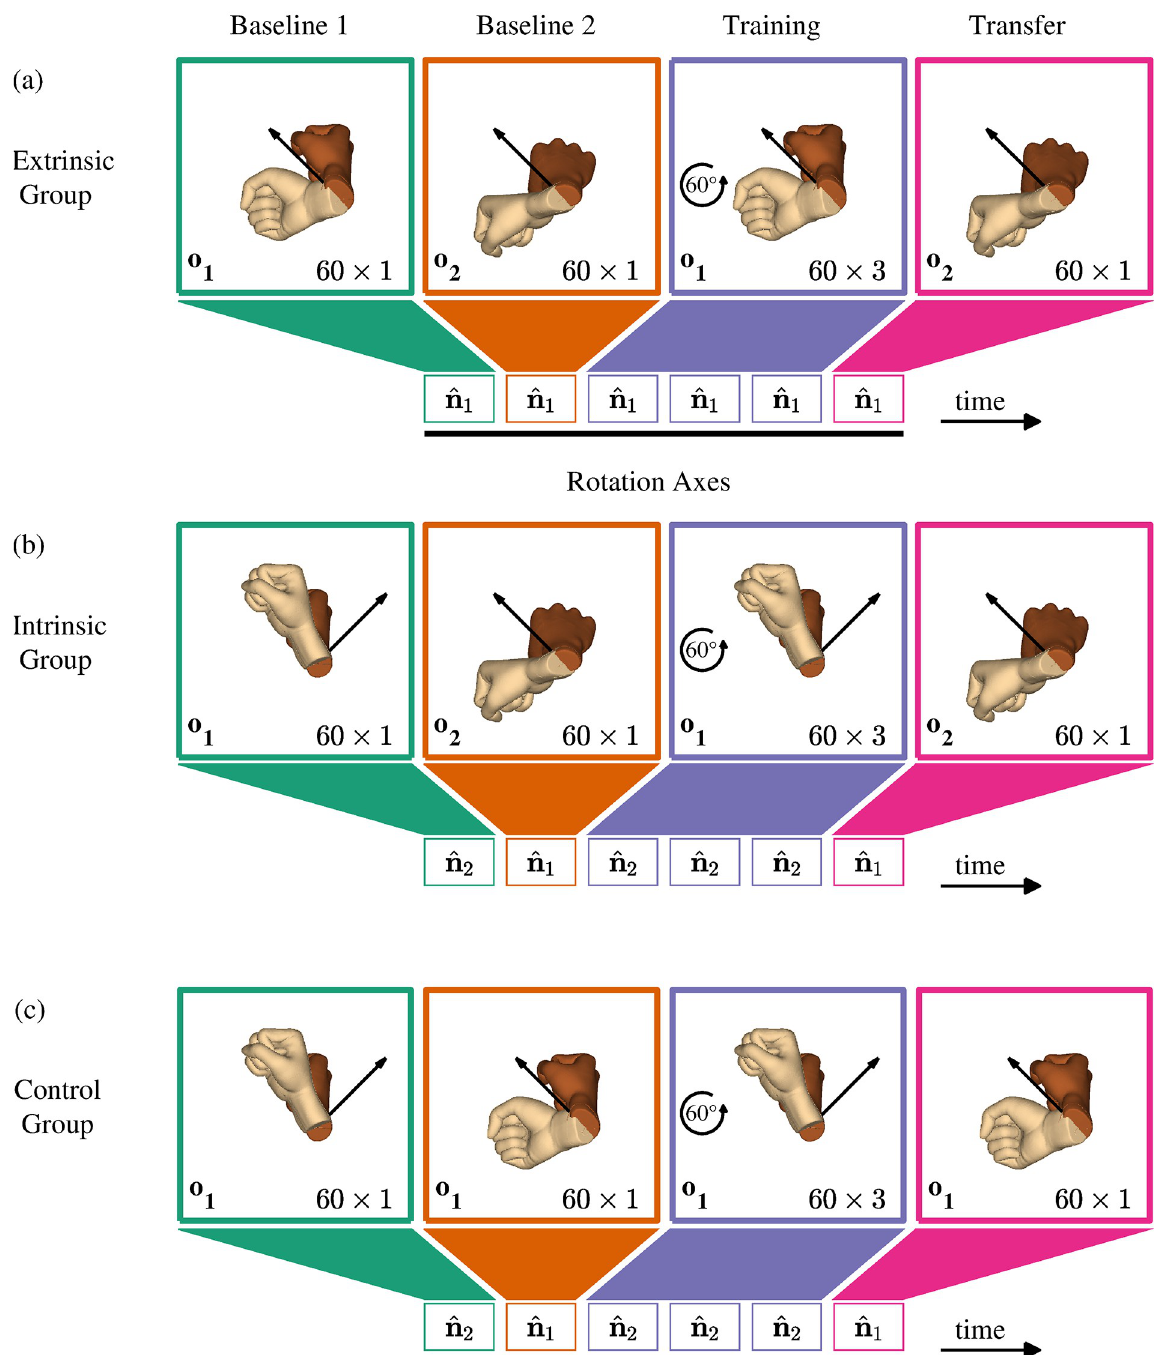
Fig 3. Experimental design and participants groups—experiment 2. All participants performed two sets of 60 baseline trials, three sets of 60 training trials, in which the cursor’s rotation was perturbed by 60˚ around ^ i , and one set of 60 transfer trials, in which the perturbation was removed. The black rotation axes are drawn with respect to an extrinsic reference frame. The initial cursor and target orientations in each set of trials are represented by the dark and light hands, respectively. The colors represent different sessions of BL (BL1—green, BL2—orange), TRN (blue) and TFR (pink). (a) Participants in the Extrinsic group performed all rotations towards similar targets in extrinsic coordinates—we rotated the initial orientation by 50˚ around ^ n all rotations towards similar targets in intrinsic coordinates—we rotated the initial orientation by 50˚ around ^ n coordinates). In both groups, trials in BL1 and TRN started from o 1 , and trials in BL2 and TFR started from o 2 . (c) To remove the effect of initial hand orientation, participants in the Control group started all rotations from o 1 . The targets in BL1 and TRN were similar to those in BL1 of the Intrinsic group, and the targets in BL2 and TFR were similar to those in BL1 of the Extrinsic group.